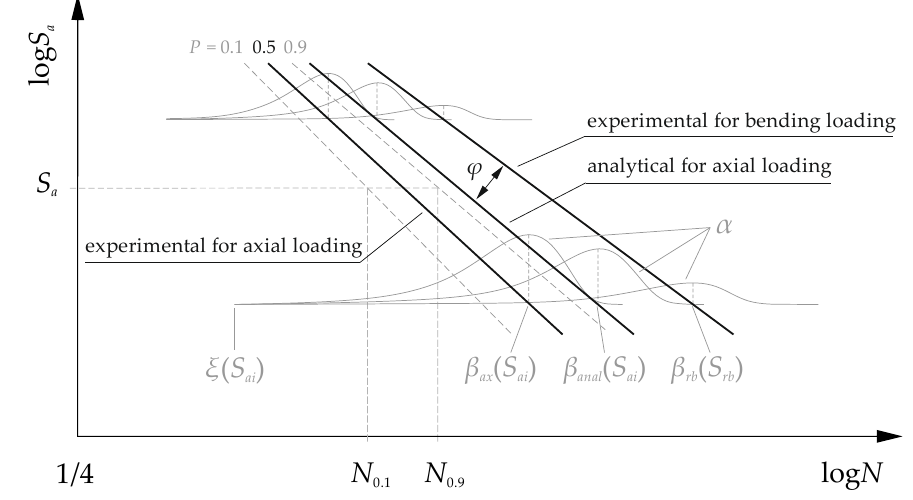
Figure 1. Scheme for S-N characteristics estimation taking into account the probability of failure P and the corresponding fatigue life N 0.1 , N 0.9 for constant stress amplitude S a .